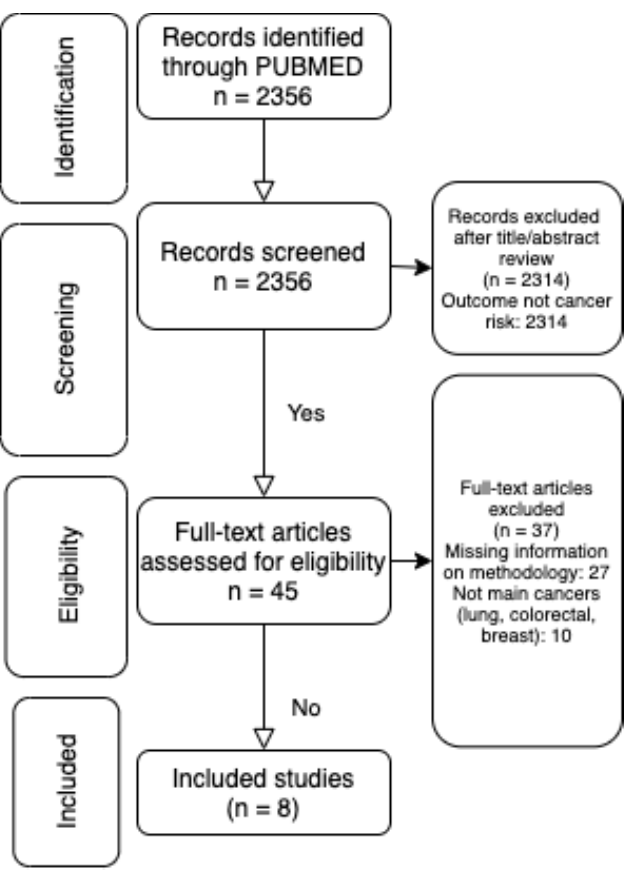
Figure 3. PRISMA diagram representing the review strategy. Table 5. Overview of observational studies included in our